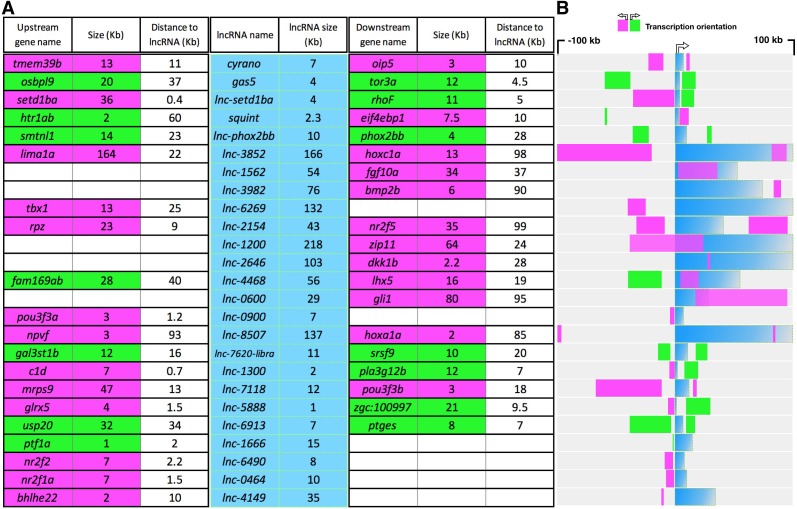
Size, relative distance and orientation of selected lncRNAs and their neighboring genes(A) lncRNA names and sizes are shown in the middle section (blue columns). The distance, size and transcriptional orientation of the neighboring genes, in a 200 kb window centered on lncRNA’s TSS are shown on the left (upstream neighbor) and on the right (downstream neighbor). The transcription orientation is represented by green (in the same direction as lncRNA) and magenta (in the opposite direction of lncRNA). (B) Visual representation of data in A. All sizes and distances are in Kb.